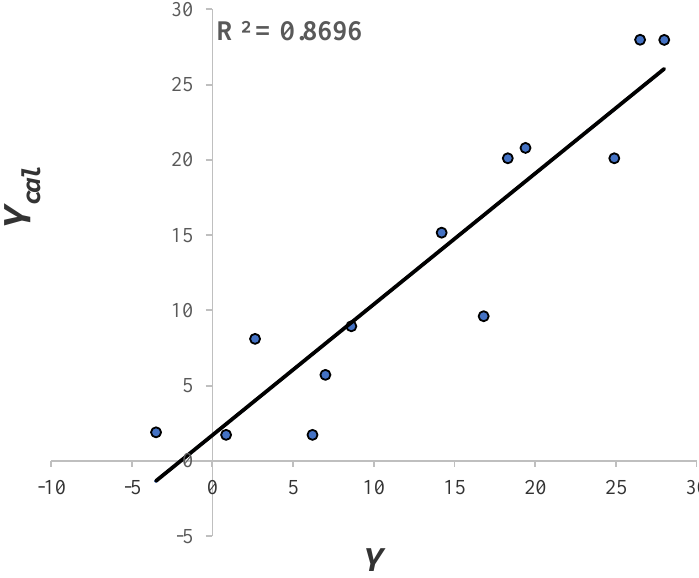
Figure 8. The linear correlation of Y cal vs. Y .